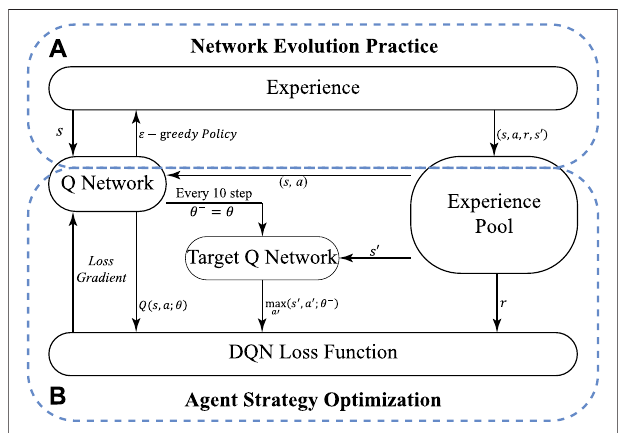
FIGURE 1 | NMDRL training fl ow. (A) is the network evolution practice part of the algorithm, (B) is the agent strategy optimization part of the